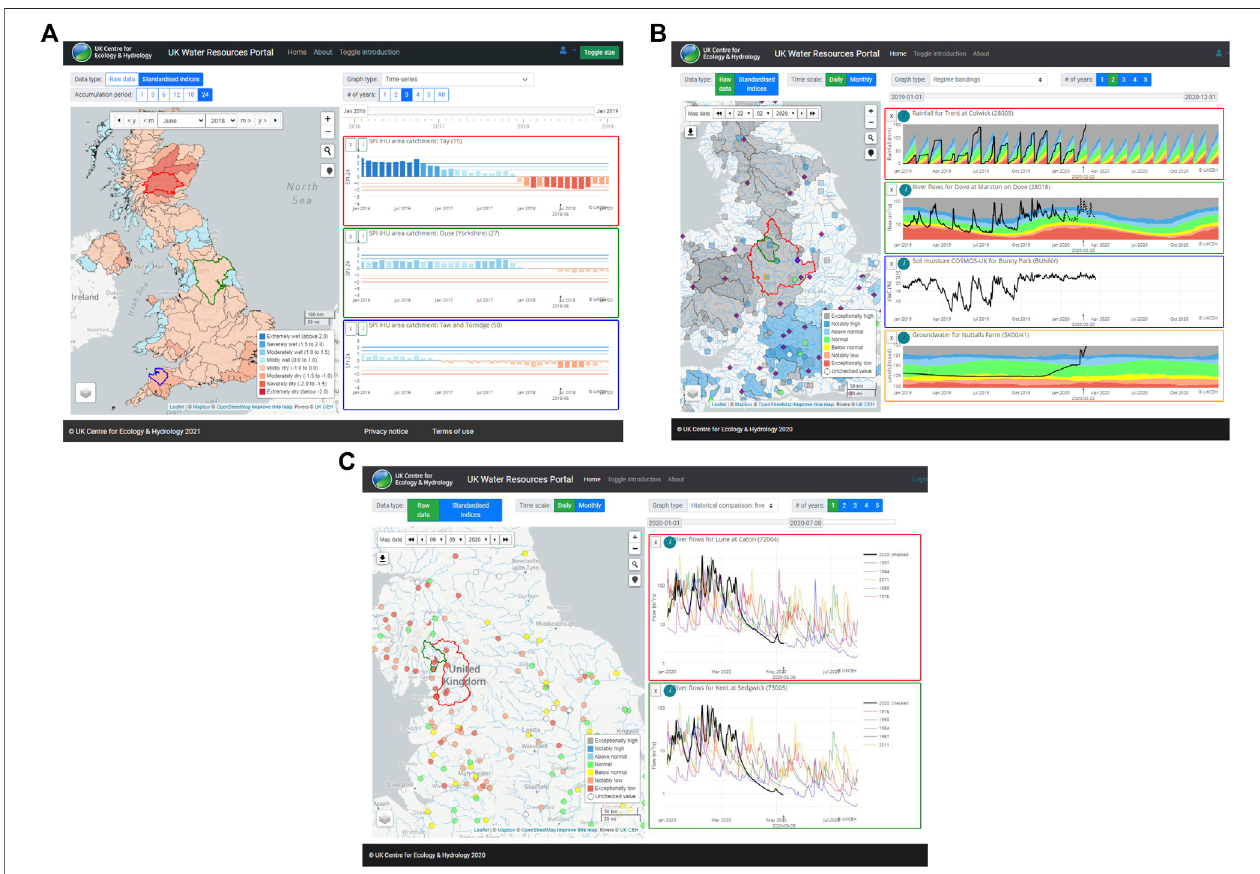
FIGURE 6 | Screenshots of the UK Water Resources Portal showing (A) SPI-24 data for June 2018 for river basins, (B) rainfall, river fl ow, soil moisture and groundwater level data for February 2020 and (C) river fl ows compared to past drought events in May 2020. Note that the user interface has changed slightly since screen shots (B,C) were taken in